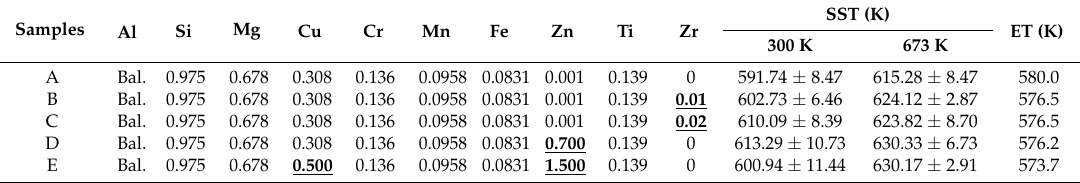
Table 1. Compositions of the five different Al alloys analyzed in this study and their shrinkage starting temperatures (SST) and eutectic temperatures (ET). The SST was measured by a displacement sensor and ETs were calculated by the J-mat pro commercial